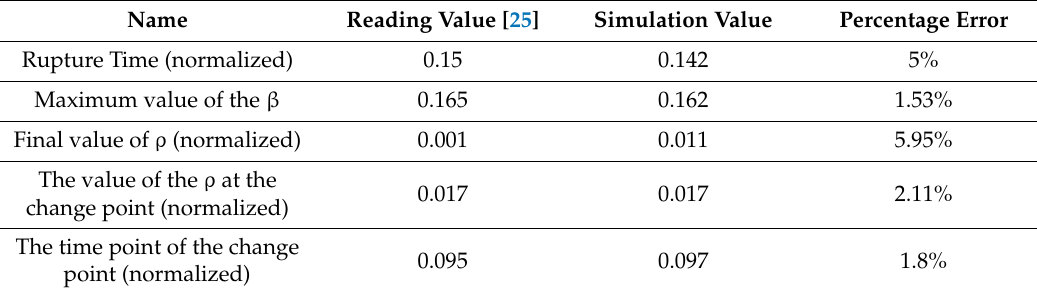
Table 3. Percentage error of these five important indicators.